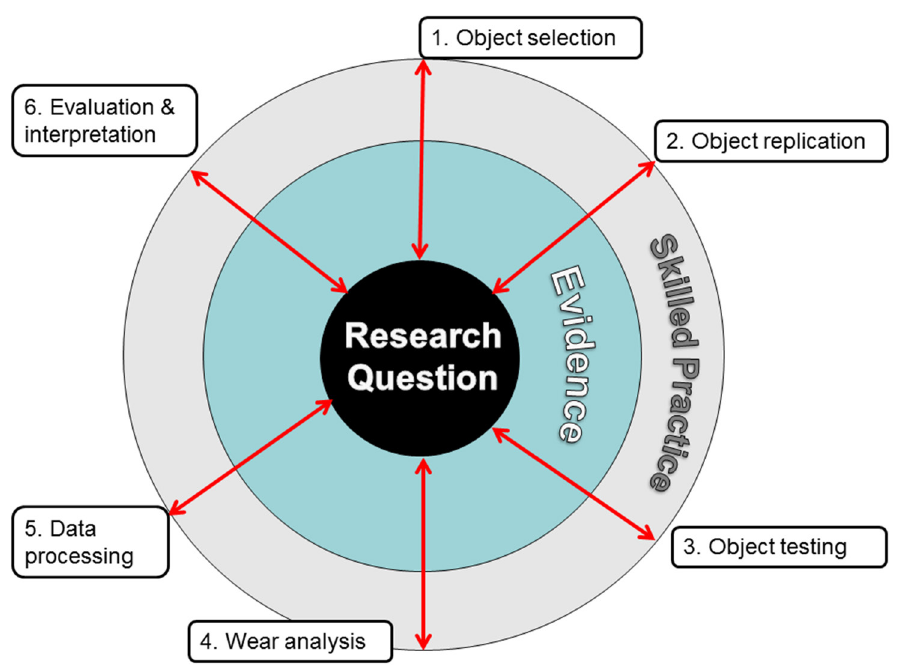
Figure 2. Our model, as utilised by the Bronze Age Combat